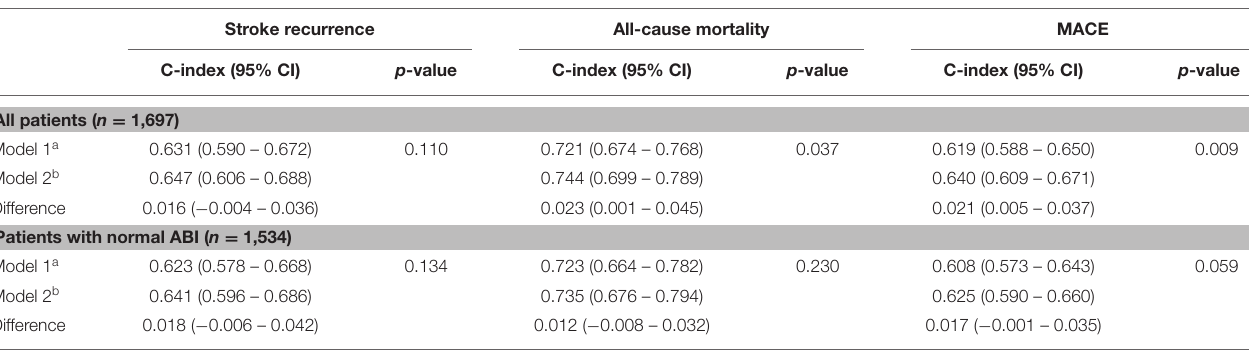
TABLE 4 | Harrell’s C-index for predicting long-term outcomes. Stroke recurrence All-cause mortality